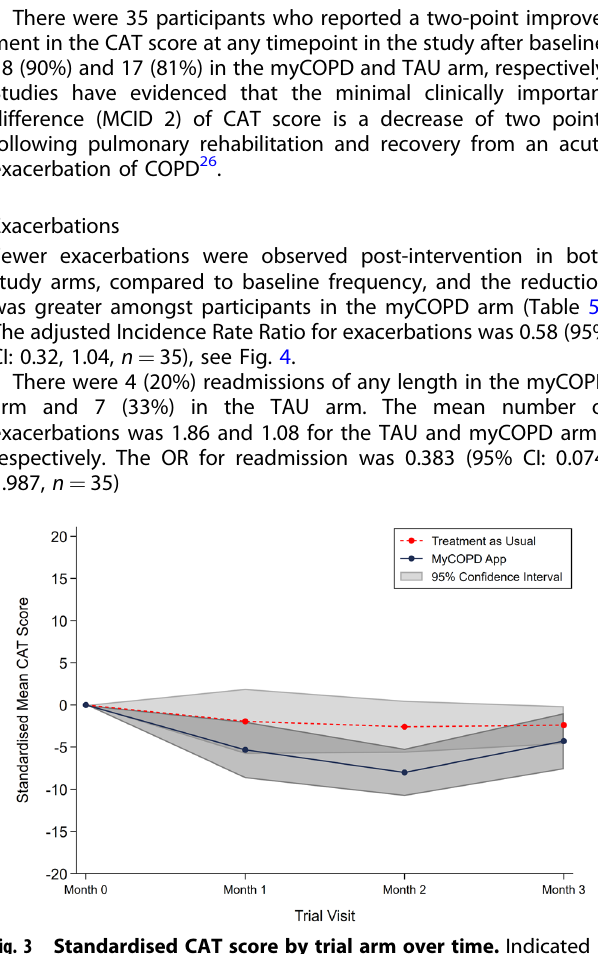
Fig. 4. The number of critical inhaler errors was greater according to the number of different inhalers used, which may mean participants duplicate errors across all their inhalers, in fl ating the effect of error ‘ types ’ , although the mean number of inhalers was similar between arms at baseline and at 90 days.